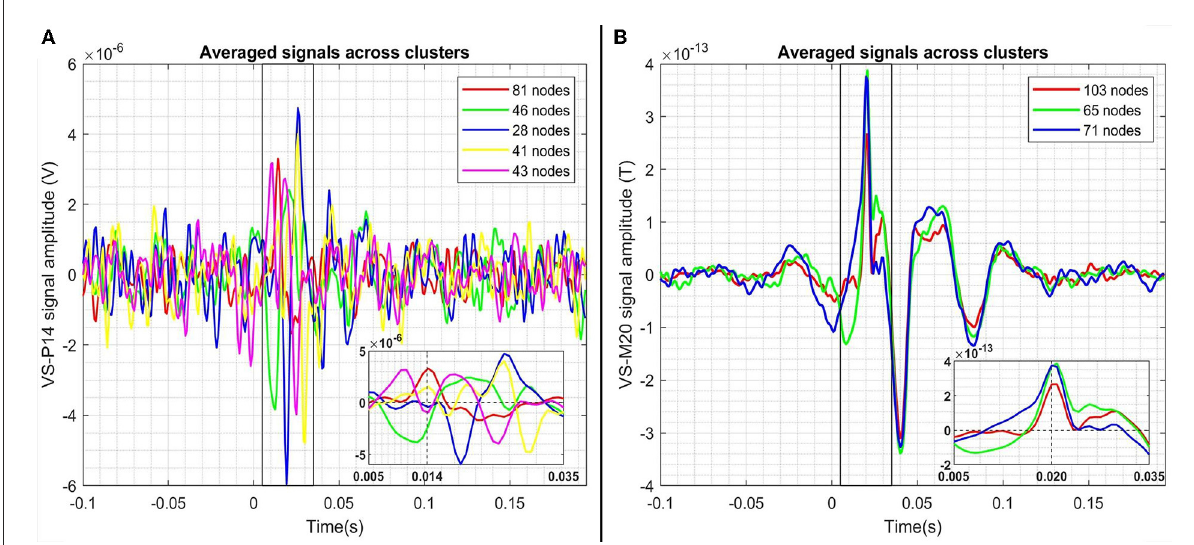
FIGURE8 The mean of the signals belonging to each of the clusters of the two different virtual sensor’s data. (A,B) Show the mean of the trials in each cluster for the P14-Vs (thalamus) and the M20-VS, respectively. On the right bottom of each plot, a zoomed version of the cluster averages is displayed in the time window from 10 to 40 ms post-stimulus.